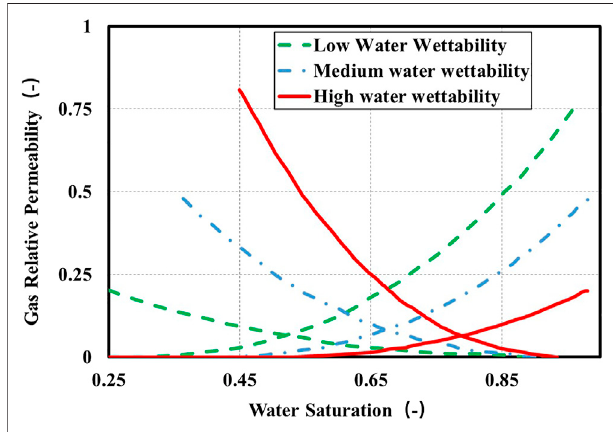
FIGURE 7 | Changing curves of the cumulative water production after 10-day shut-in and 3-year production for different initial water saturation degrees.